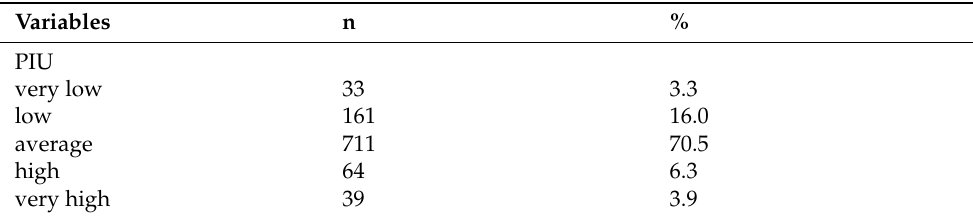
Table 2. PIU measurement results—risk categories of Internet